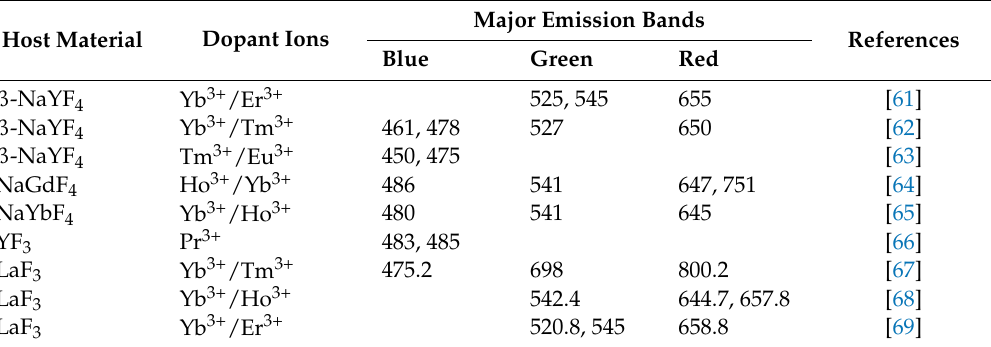
Table 1. Emission bands of the rare earth doped some host materials.